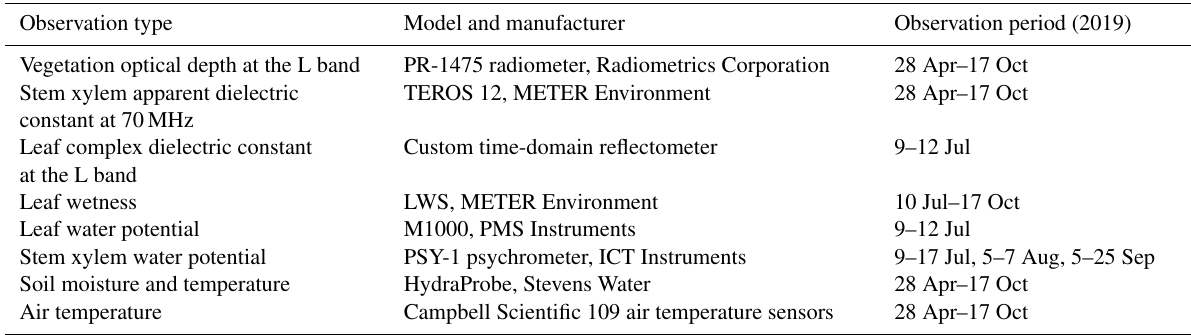
Table 1. Summary of data collected. Note that the stem xylem water potential sensor operated for three periods with gaps in